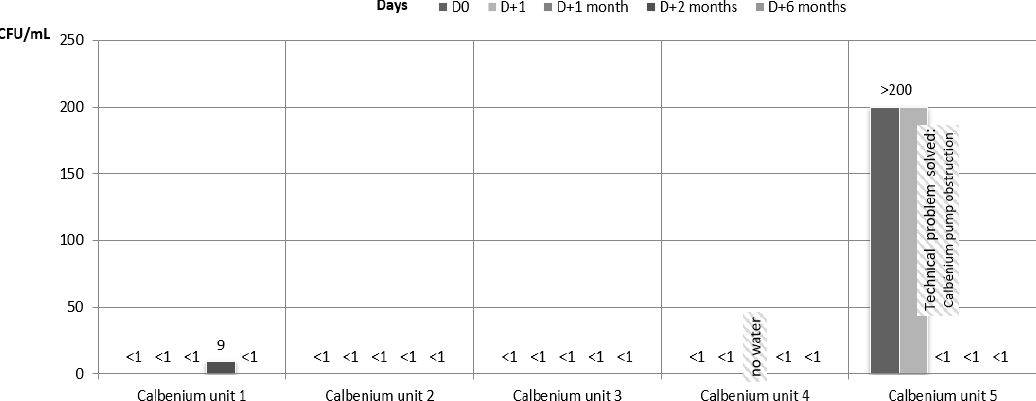
Figure 5. Microbiological quality of the water samples for the units connected to the IGN Calbenium ® system. HPC at 22°C.